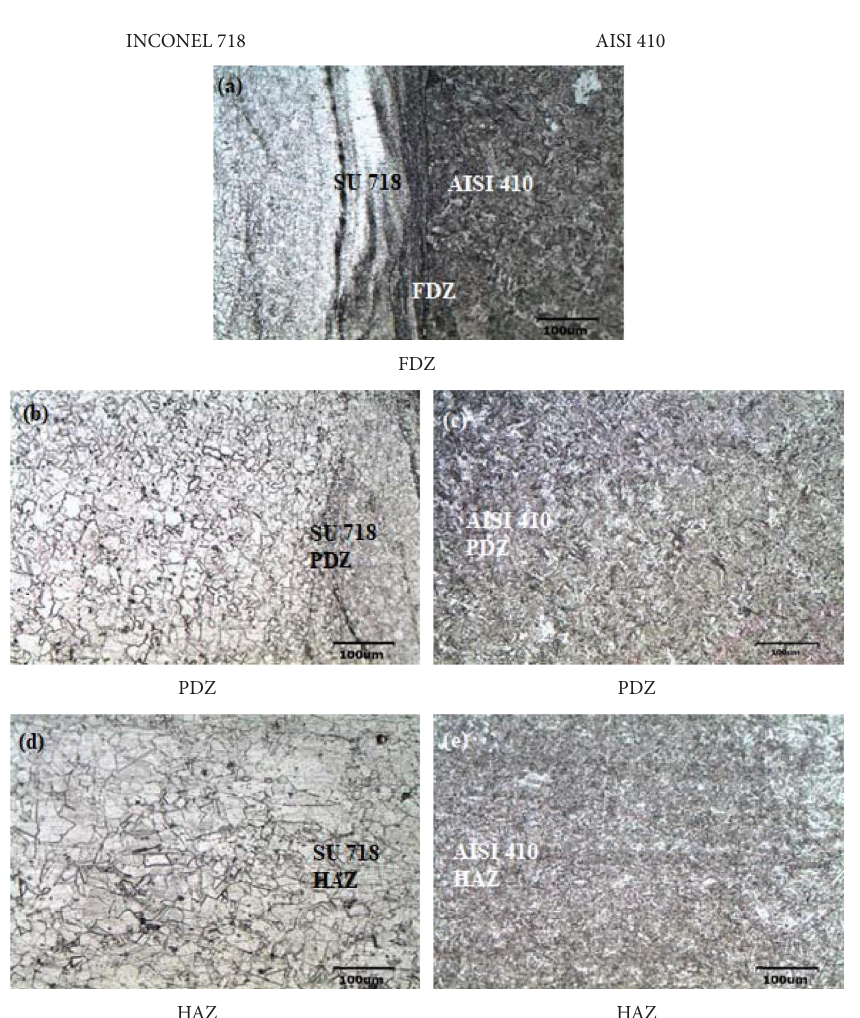
Figure 5: Dissimilar weld joint microstructure at